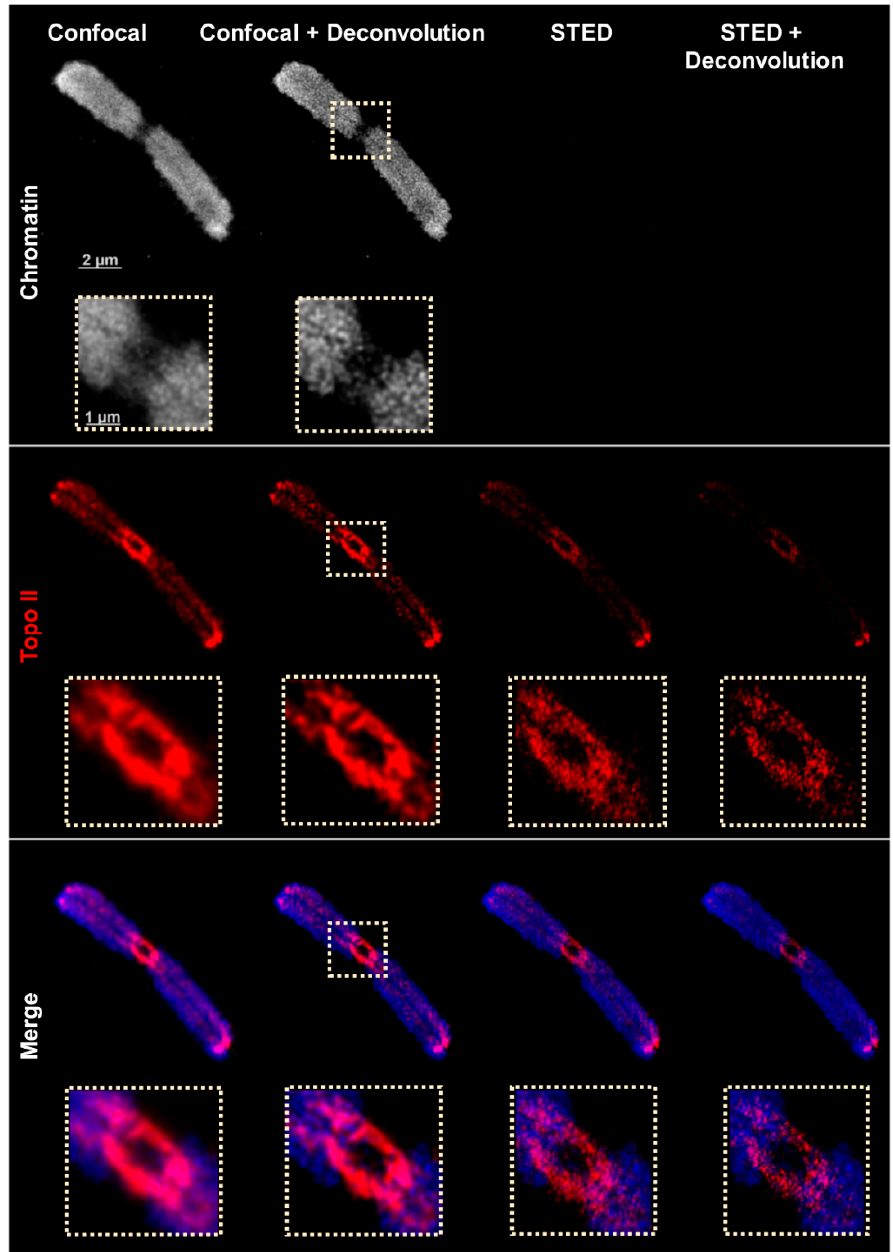
Figure 3. Distribution of Topo II visualized by confocal, confocal + deconvolution, and stimulated emission depletion (STED) + deconvolution using STAR635P-labeled secondary antibodies desig- nated for STED. The enlarged regions (dashed rectangles) show clearly the improved resolution achieved via STED. Only one representative slice from the Z image stack is shown in all images. The STED images were merged with confocal DAPI-labeled chromatin images (blue).